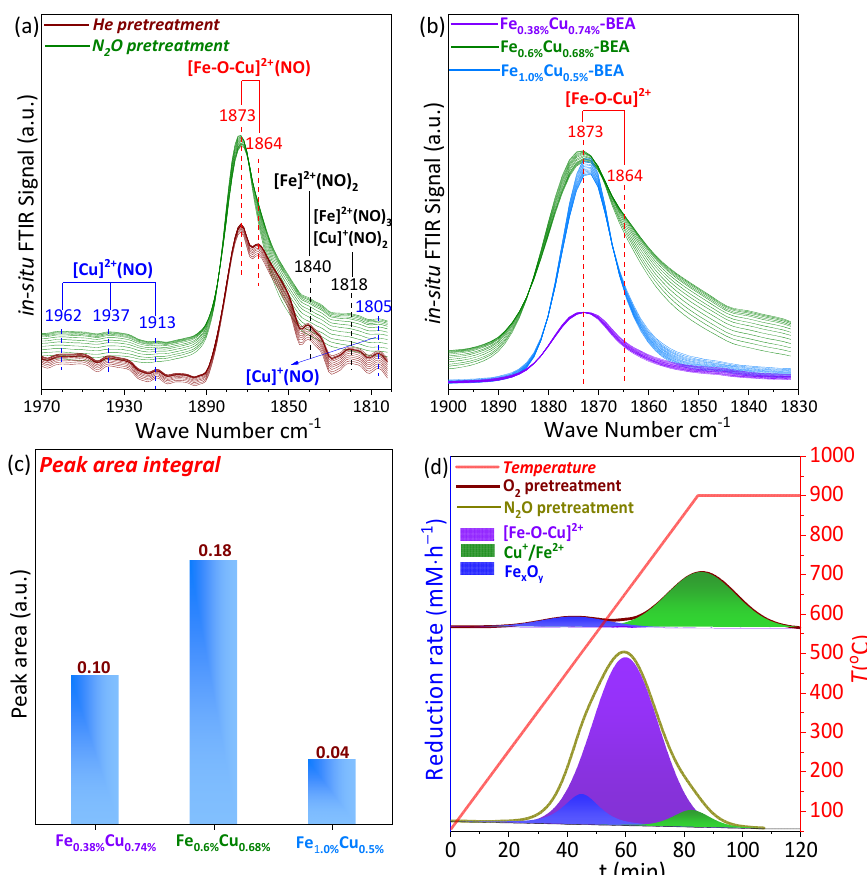
Figure 3. ( a ) In situ FTIR with NO as the probe molecule over Fe 0.6% Cu 0.68% -BEA after the in situ pretreatment by He (>99.999 vol%, 40 mL ∙ min − 1 at T = 500 °C for 1 h) and N 2 O (30 vol% in He, 40 mL ∙ min − 1 at T = 250 °C for 1 h); as noted, during the N 2 O pretreatment, the sample was also initially pretreated with He at 500 °C for 1 h and subsequently pretreated with N 2 O; ( b ) NO in situ FTIR of the Fe n Cu m -BEA samples after the N 2 O pretreatment; ( c ) peak area comparisons of 1873 and 1864 cm − 1 in panel ( b ) for the Fe n Cu m -BEA samples; ( d ) H 2 -TPR of Fe 0.6% Cu 0.68% -BEA after the O 2 and N 2 O pretreatment; this specific pretreatment strategy is similar to that utilized during NO in situ FTIR.